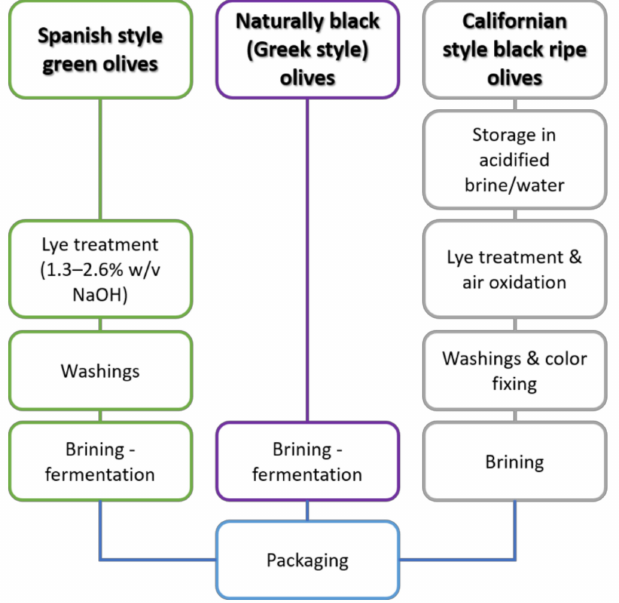
Figure 5. Production process flow charts for Spanish-style green olives, Californian-style black-ripe olives, and naturally black olives in